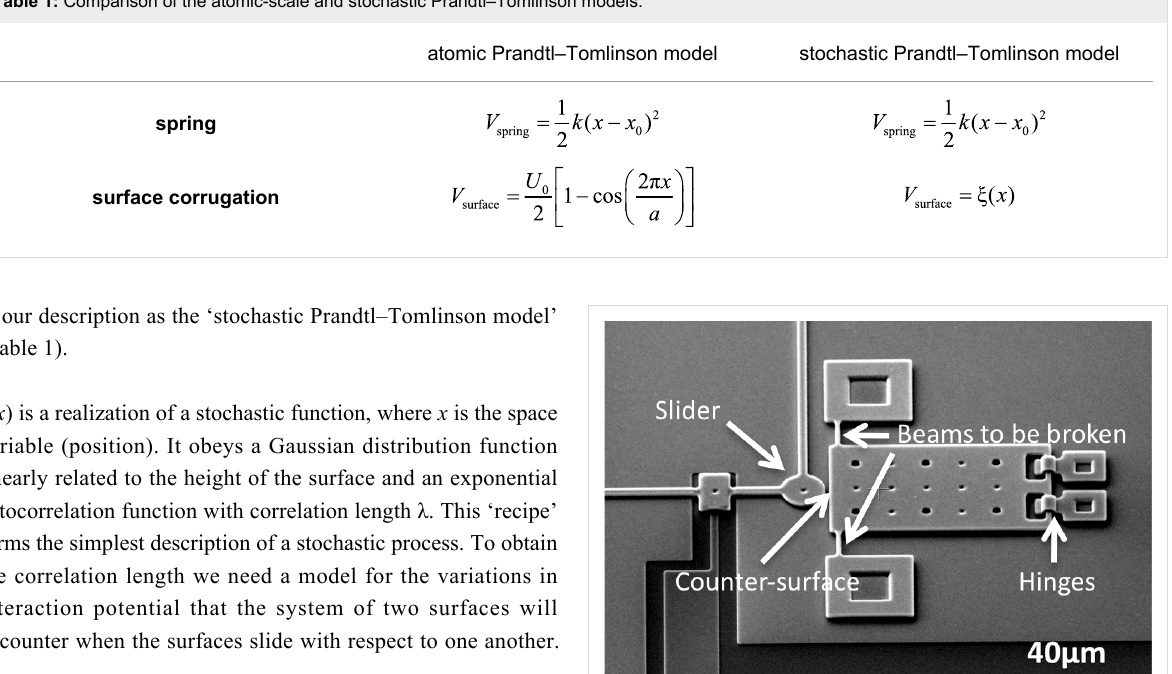
Table 1: Comparison of the atomic-scale and stochastic Prandtl–Tomlinson models.